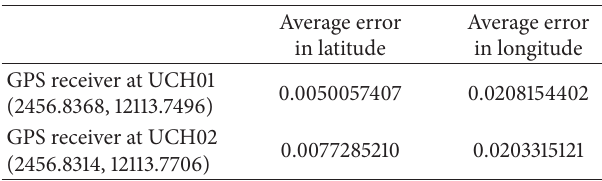
Table 4: Average error between GPS receivers and reference